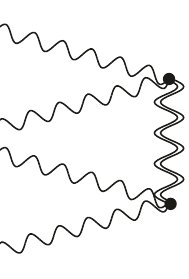
Figure 3 . Gauge boson scattering induced by 5D